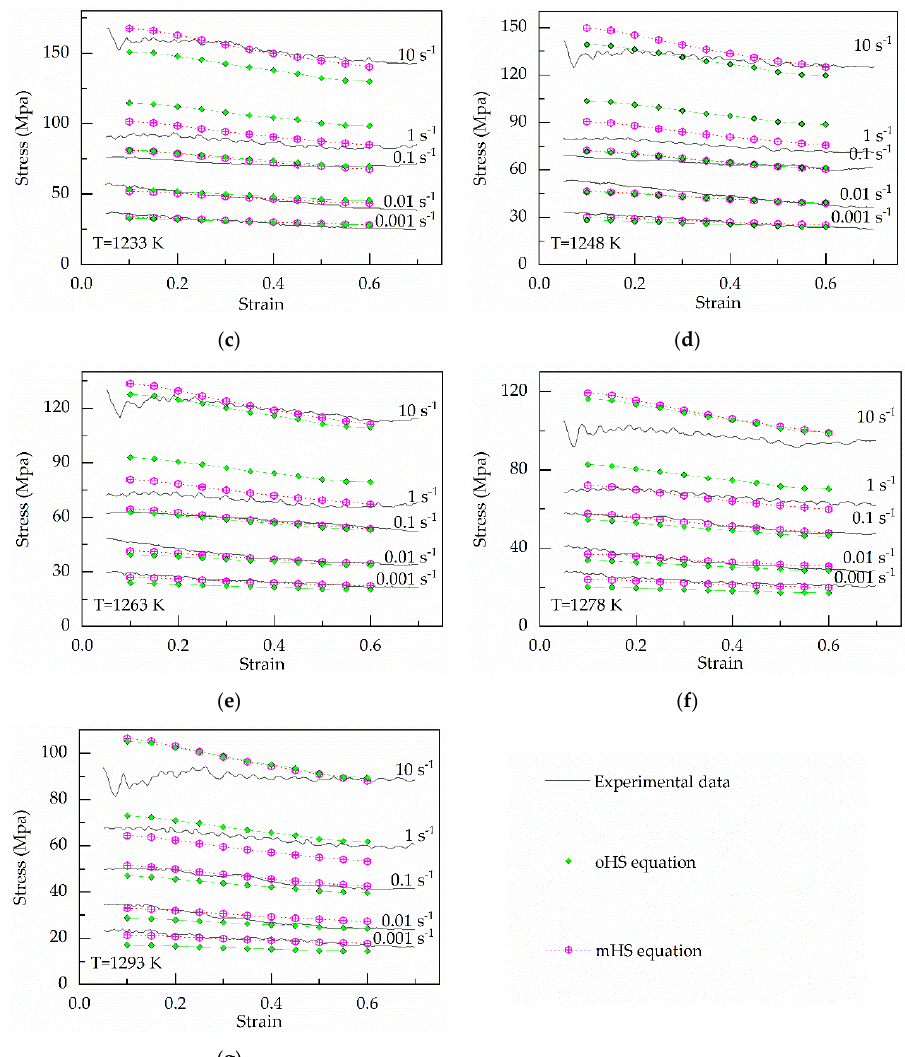
Figure 14. Comparison between the experimental and predicted stress from the original Hensel– Spittel (oHS) equation and the modified Hensel–Spittel (mHS) equation at ( a ) 1203 K; ( b ) 1218 K; ( c ) 1233 K; ( d ) 1248 K; ( e ) 1263 K; ( f ) 1278 K; ( g ) 1293 K.